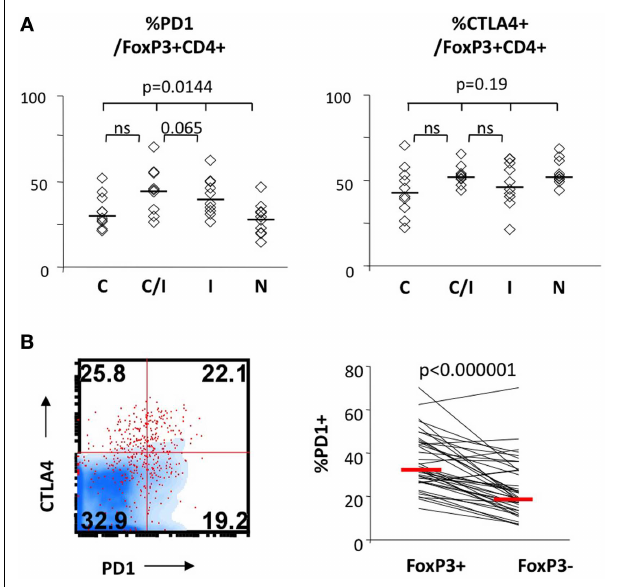
FIGURE 3 | FoxP3 + Treg expression levels of PD-1 and/or CTLA-4 in patients with HCV and/or HIV infection . (A) Frequency of FoxP3 + Tregs expressing CTLA-4 and PD-1 are compared between 10 HCV-monoinfected (C), 9 HCV/HIV-coinfected (C/I), 10 HIV-monoinfected (I), and 10 seronegative control subjects ( N ). Horizontal bars indicate median values. P -values are calculated with non-parametric Kruskal–Wallis for comparison between all four groups.Two-way comparison of HCV/HIV coinfection group with HCV or HIV monoinfection group was made using non-parametric Mann–Whitney U and corrected for multiple comparisons. (B) Relative frequencies of cells expressing PD-1 in FoxP3 + CD4T cells and FoxP3 − CD4T cells are compared in a representative FACS overlay on the left panel (FoxP3 + CD4T cells as red dot plot, FoxP3 − CD4T cells in blue density plot) and in pair-wise comparison in 10 HCV, 9 HCV/HIV, 10 HIV, and 10 seronegative control. P -value is calculated by paired t -test.